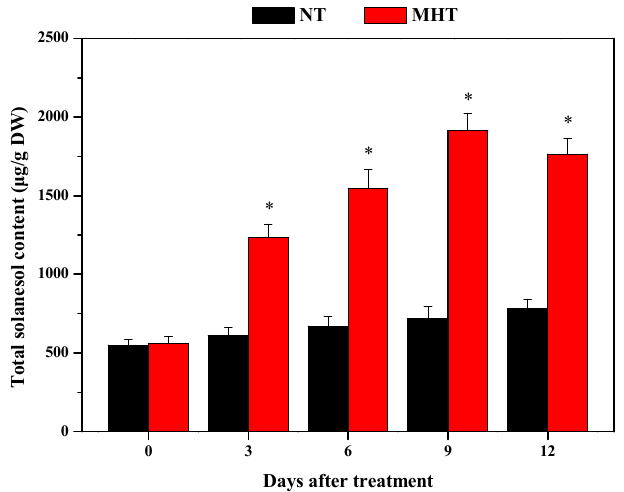
Figure 1. Total solanesol content of tobacco leaves grown at normal temperature (NT) and moderately high temperature (MHT). The asterisk (*) indicates p < 0.05. DW – dry weight.